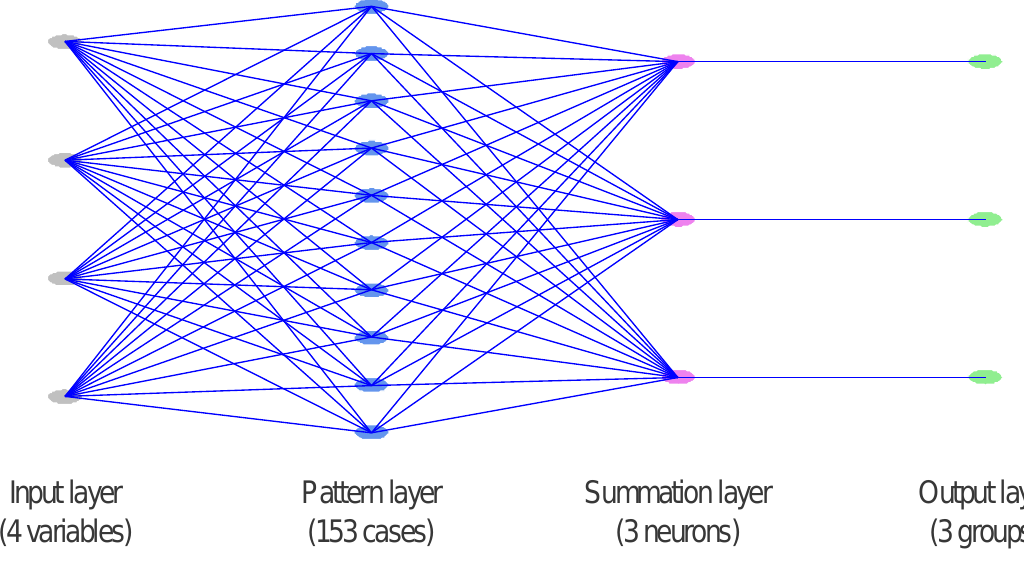
Figure 3. Probabilistic Neural Network classifier developed in the study.